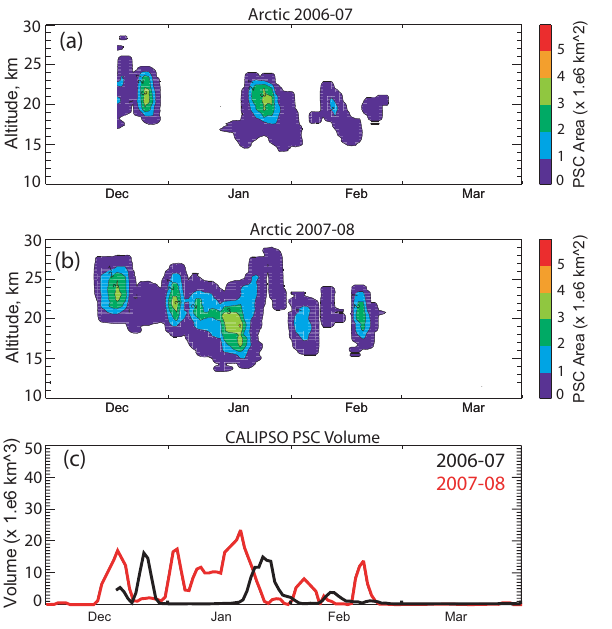
Fig. 12. Daily time series of CALIPSO PSC area as a function of altitude for the (a) 2006–2007 and (b) 2007–2008 Arctic seasons. The total volume PSC coverage for both years is shown in panel (c) .